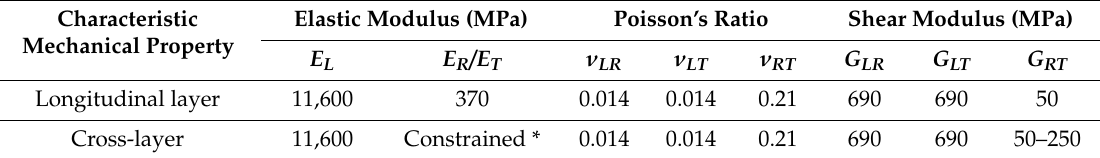
Table 2. Mechanical properties used in FE models and analytical methods to calculate deflections.